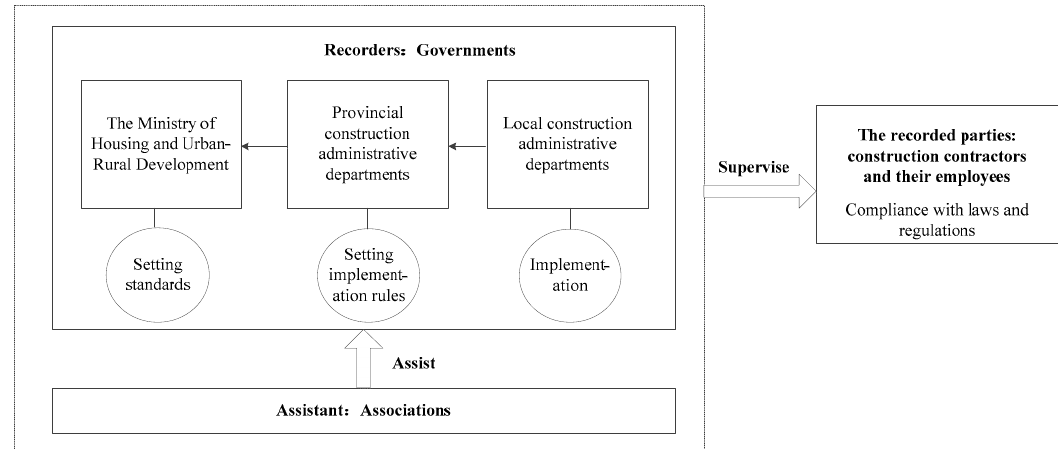
Figure 1. Relationships among participants and their duties.